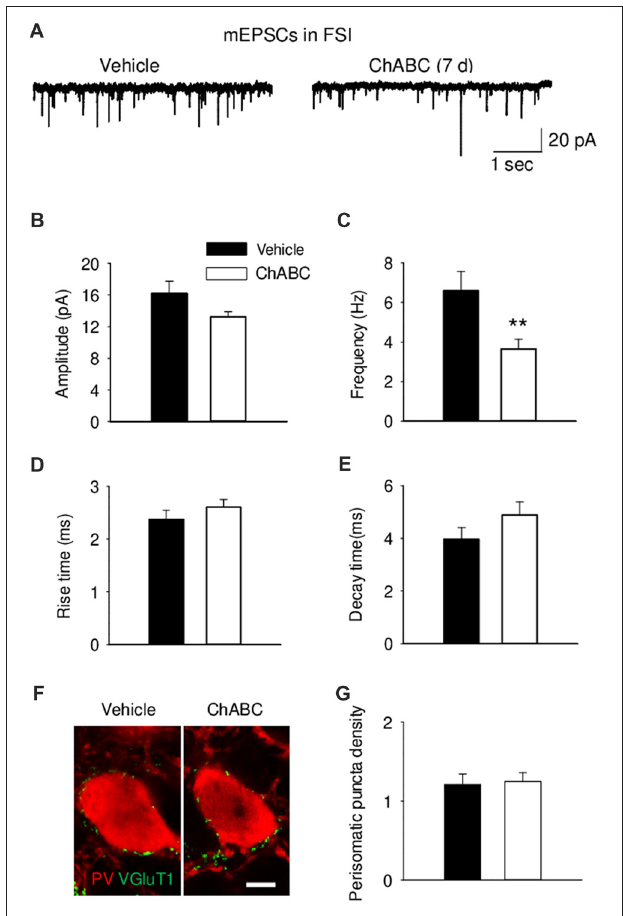
FIGURE 5 | Decreased frequency of action-potential independent miniature EPSCs (mEPSCs) onto fast-spiking interneurons 7 days (7 d) after ChABC injection. Representative traces (A) , amplitude (B) , frequency (C) , rise (D) and decay time (E) of mEPSCs in FSIs after Vehicle ( n = 9) or ChABC ( n = 9) treatments. (F) Graph representing VGluT1 expression in the perisomatic region of parvalbumin (PV)-expressing FSIs. Scale bar, 5 µ m. (G) Perisomatic puncta density (number of puncta/10 µ m of soma perimeter) after treatment with Vehicle (33 neurons from three mice) or ChABC (39 neurons from three mice). Bars represent mean ± SEM values (per animal) in vehicle- (black) and ChABC-treated (white) groups. ∗∗ P < 0.01, t -test, compared with